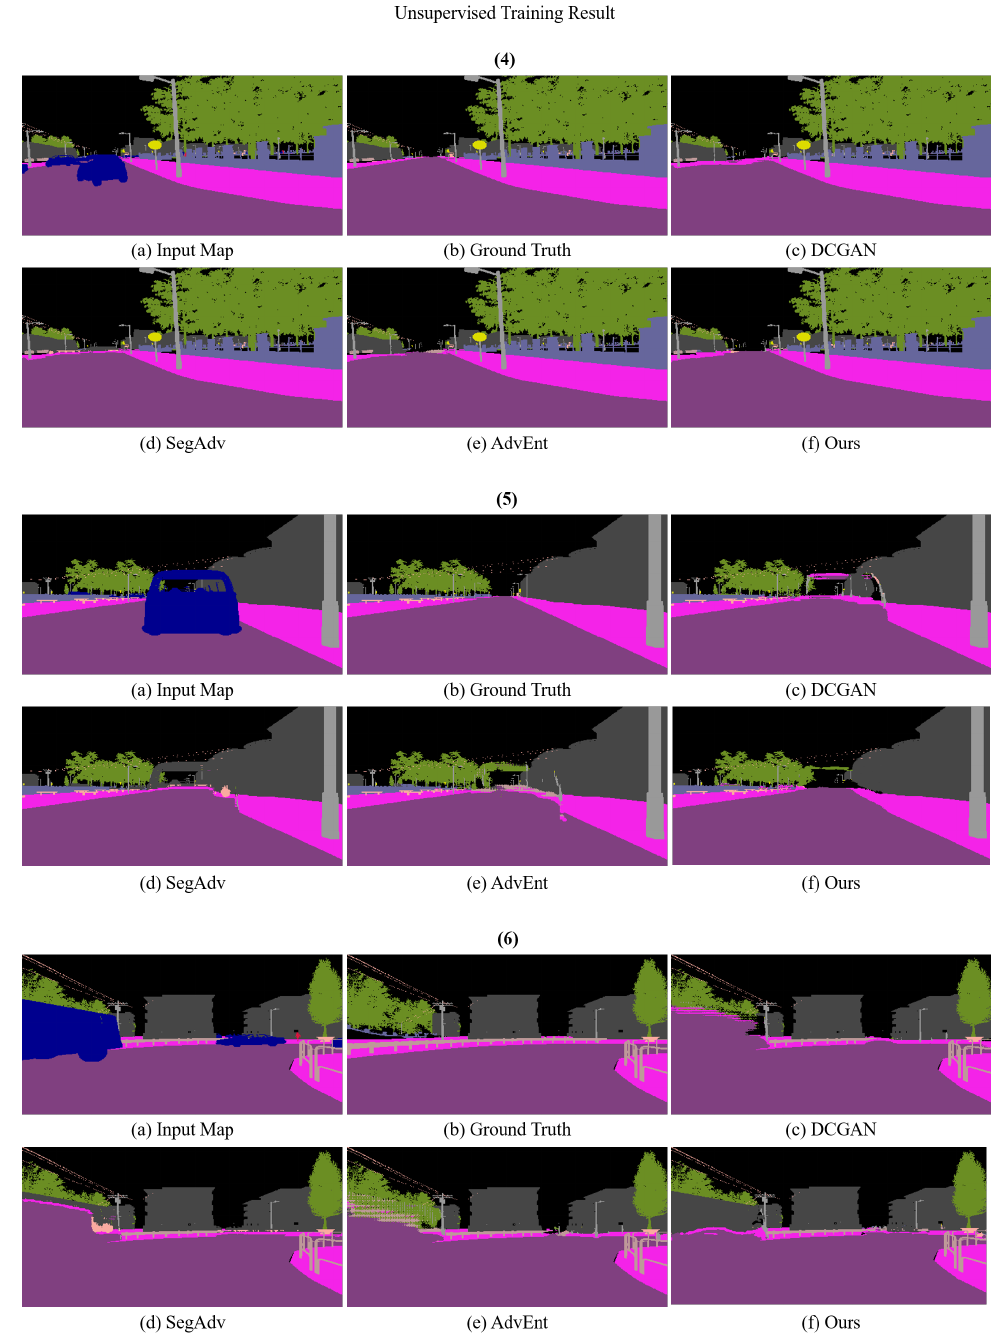
Figure 6. Additional results for the unsupervised learning-based Media Integration and Communica- tion Center Semantic Road Inpainting (MICC-SRI) qualitative results: ( a ) input map, ( b ) ground truth, ( c ) deep convolutional generative adversarial network (DCGAN) [20], ( d ) segmentation adversarial network (SegAdv) [29], ( e ) adversarial entropy network (AdvEnt) [27], and ( f ) semantic segmentation inpainting network